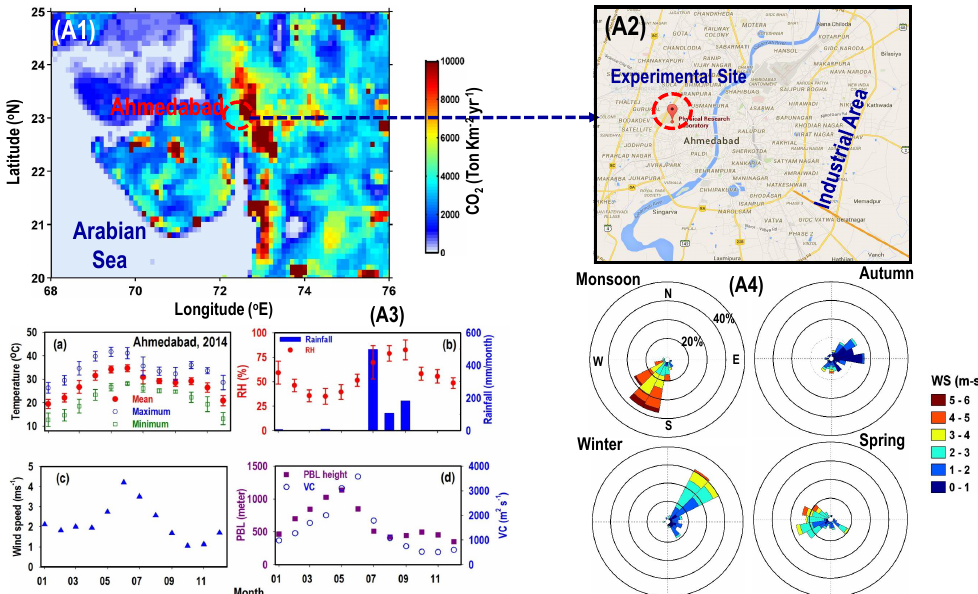
Figure 1. (A1) Spatial distribution of total anthropogenic CO 2 emissions from the EDGARv4.2 inventory over Ahmedabad and surrounding regions. (A2) The Ahmedabad city map showing location of the experimental site (PRL). ( A3 : a–d) Monthly average temperature with monthly maximum and minimum values, relative humidity (RH), rainfall, wind speed, PBL height and ventilation coefficient (VC) over Ahmedabad during the year 2014. Temperature, RH and wind speed are taken from Wunderground weather (www.wunderground.com), while rainfall and PBLH data are used from the Tropical Rainfall Measuring Mission (TRMM) satellite and MERRA reanalysis data. (A4) Wind rose plots for Ahmedabad for the four seasons of 2014 using daily averaged data from